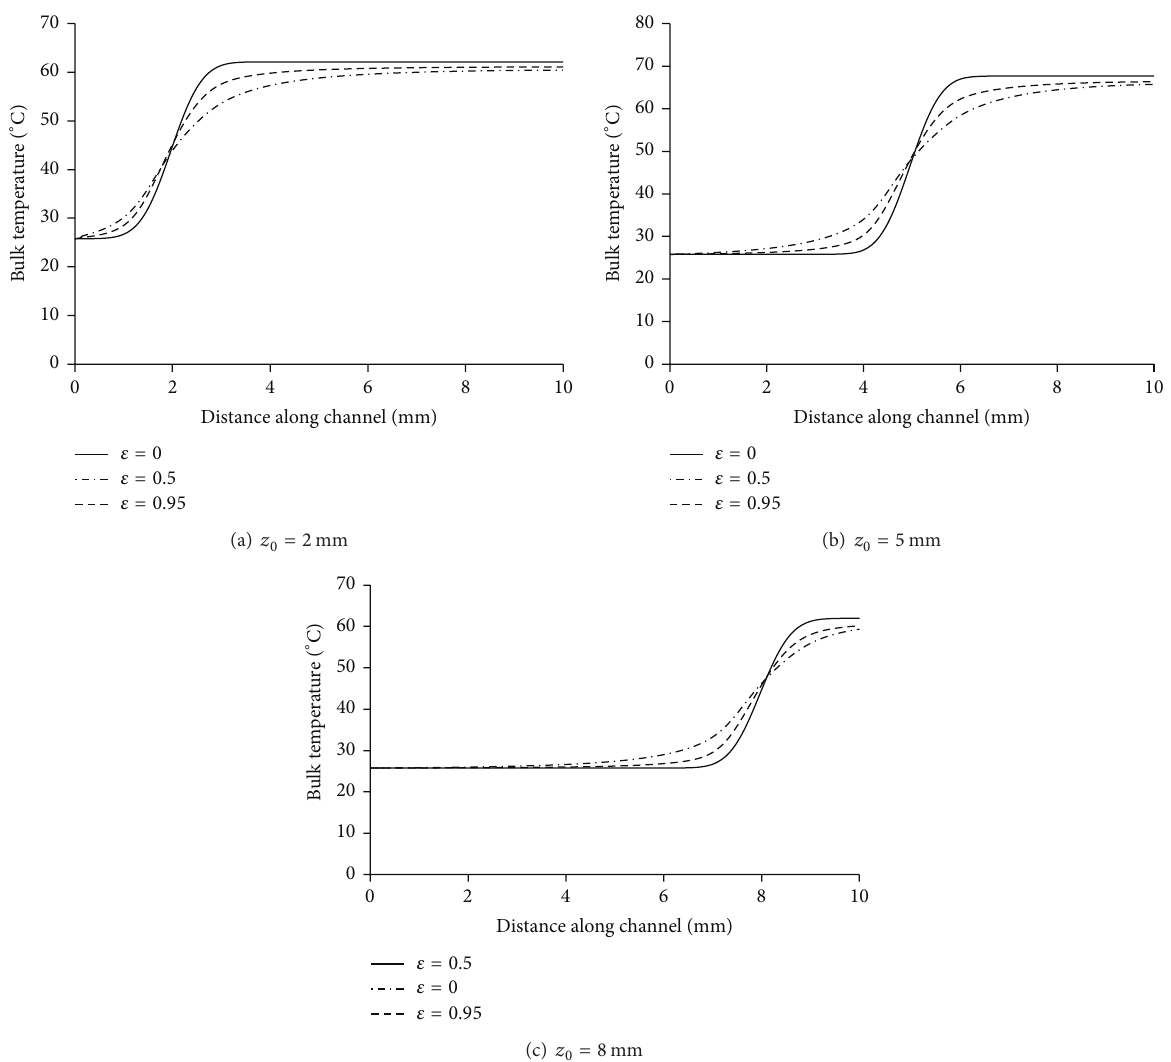
Figure 10: Variations in fluid bulk temperature obtained using different values of 𝜀 , when SD = 0.001, Re = 500, and 𝐶 = 100